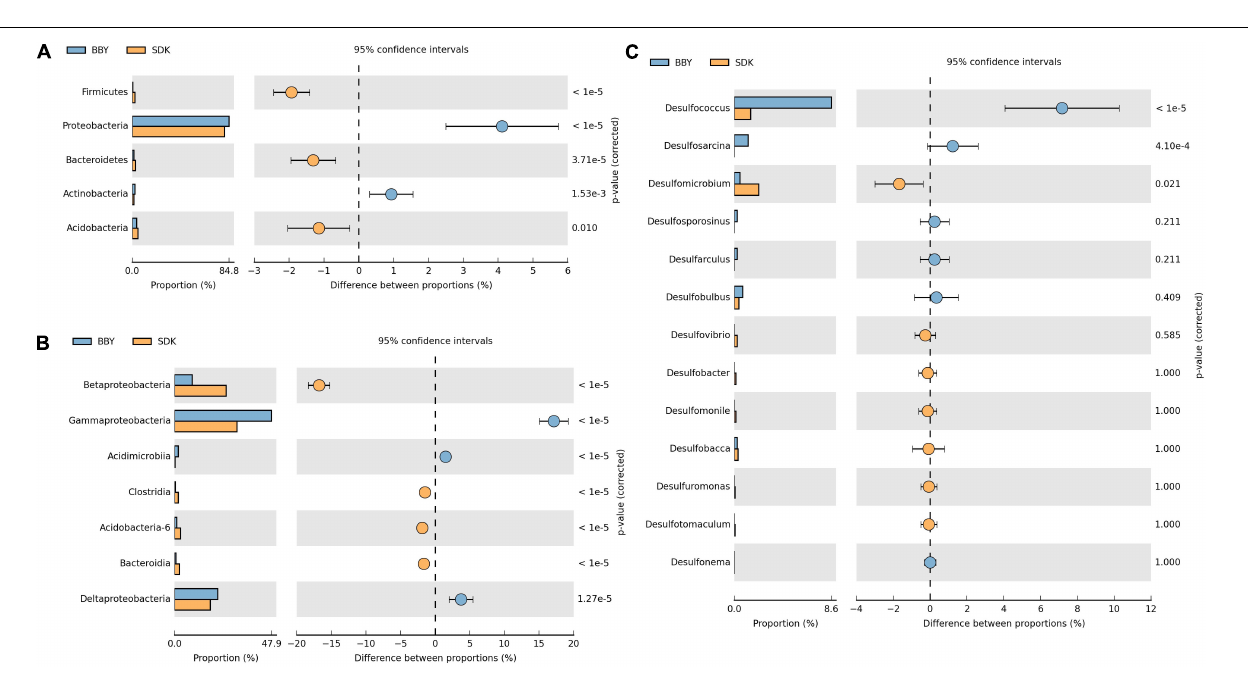
FIGURE 5 | The difference in proportions of recorded bacterial OTUs classified by dominant (A) phyla, (B) classes, and (C) sulfur-reducing bacteria in sediment samples from representative estuarine mudflat (SDK) and the Chongming salt marsh (BBY) sites, collected in October 2015. Significant difference between proportions were analyzed using Welch’s t